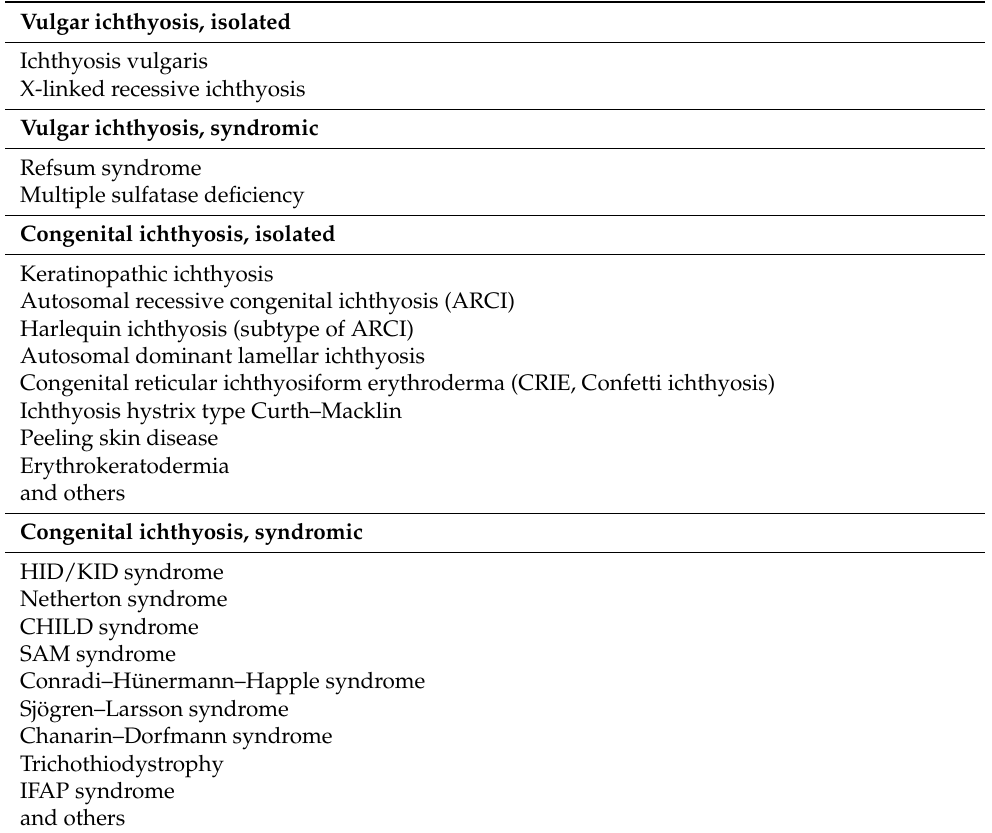
Table 1. Clinical classification of ichthyoses.